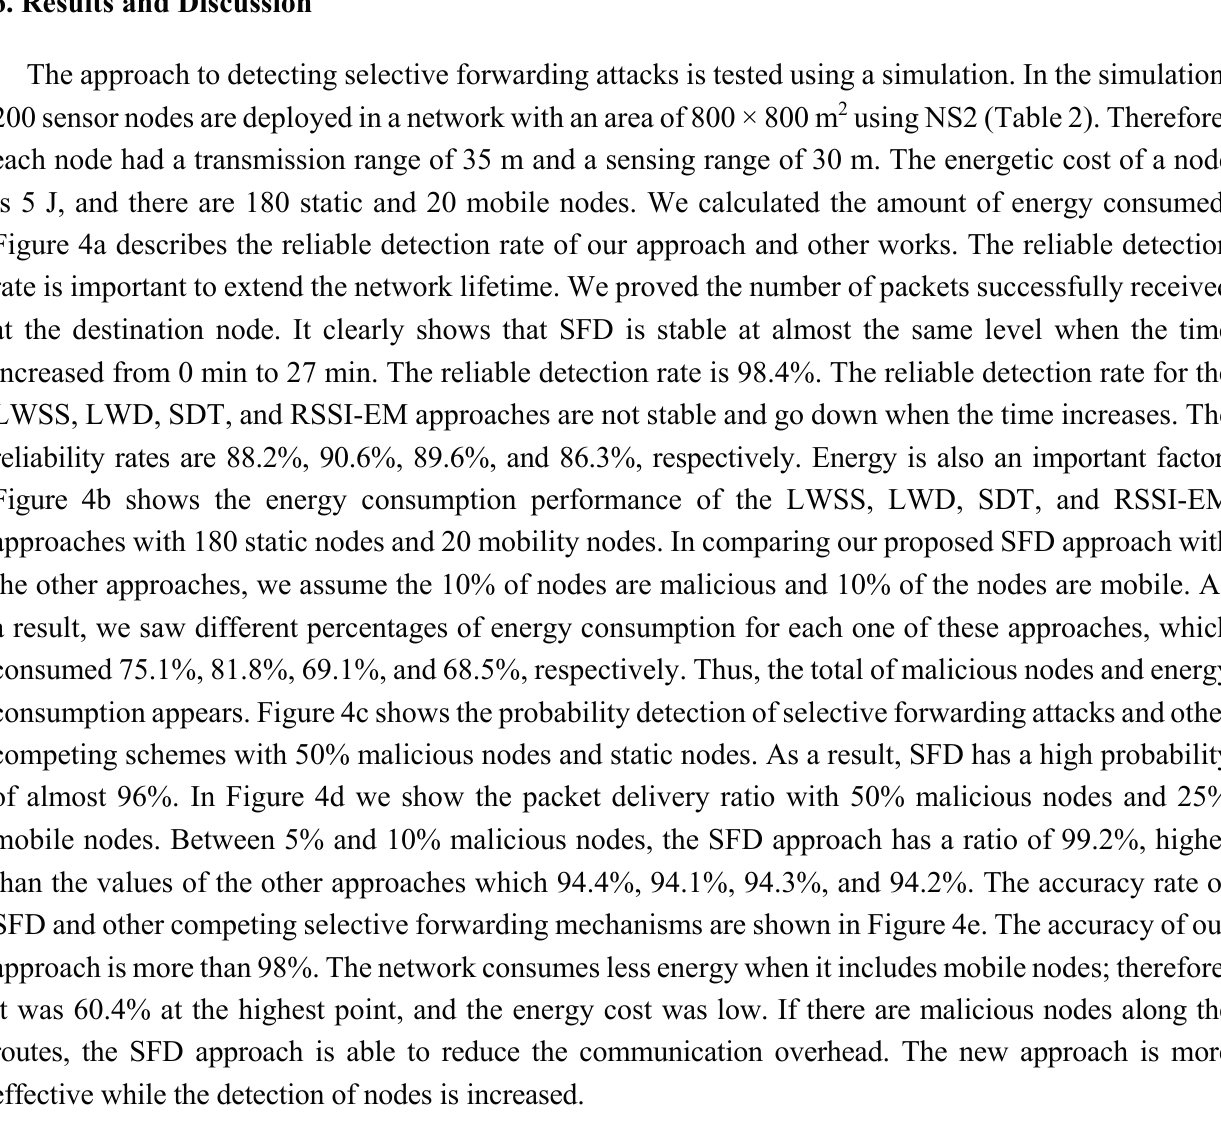
Table 2. Experiment